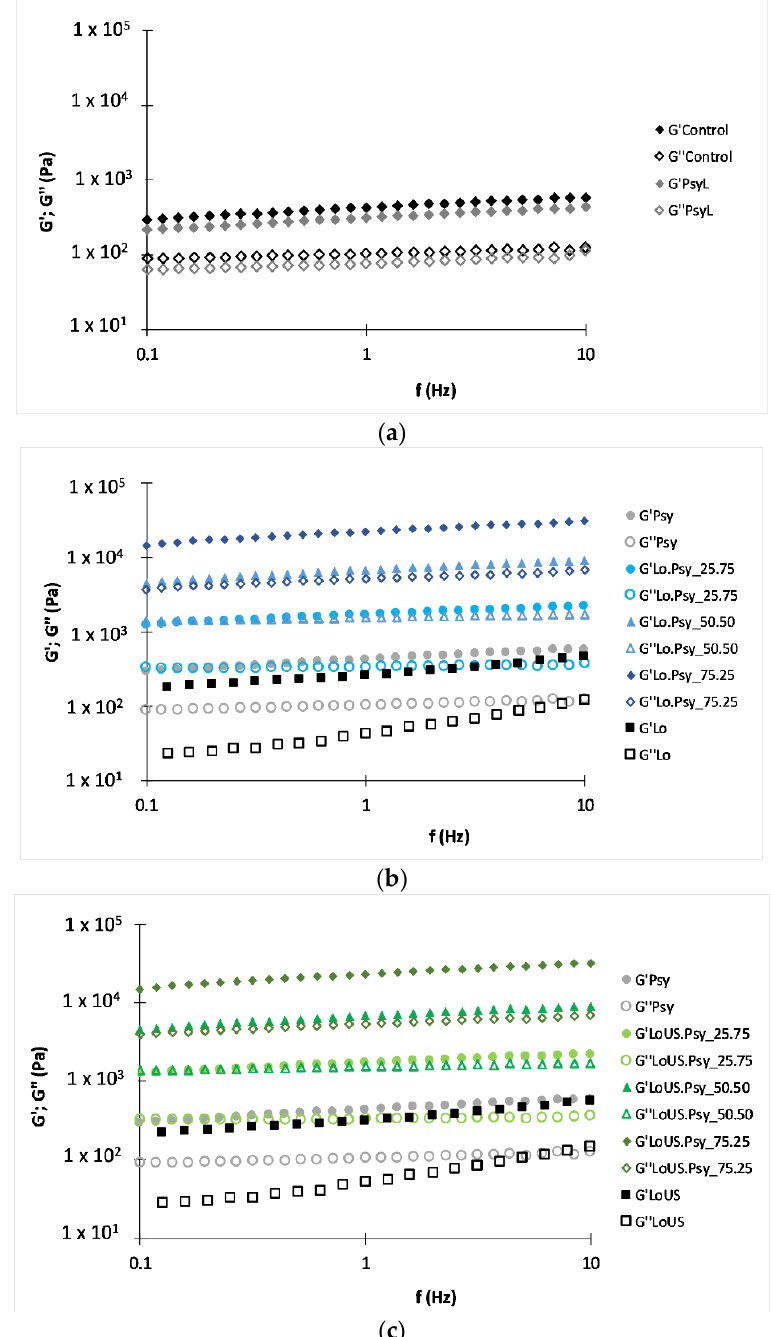
Figure 3. Mechanical spectra of the Psyllium gels prepared in water (control) and autohydrolysis liquor (PsyL).( a ) Laminaria-Psyllium gels (Lo.Psy_25.75, Lo.Psy_50.50, LoPsy_75.25); ( b ) Laminaria with ultrasonic treatment- Psyllium gels (LoUS.Psy_25.75, LoUS.Psy_50.50, LoUSPsy_75.25; ( c ) G’ , closed symbol; G’’ , open symbol.